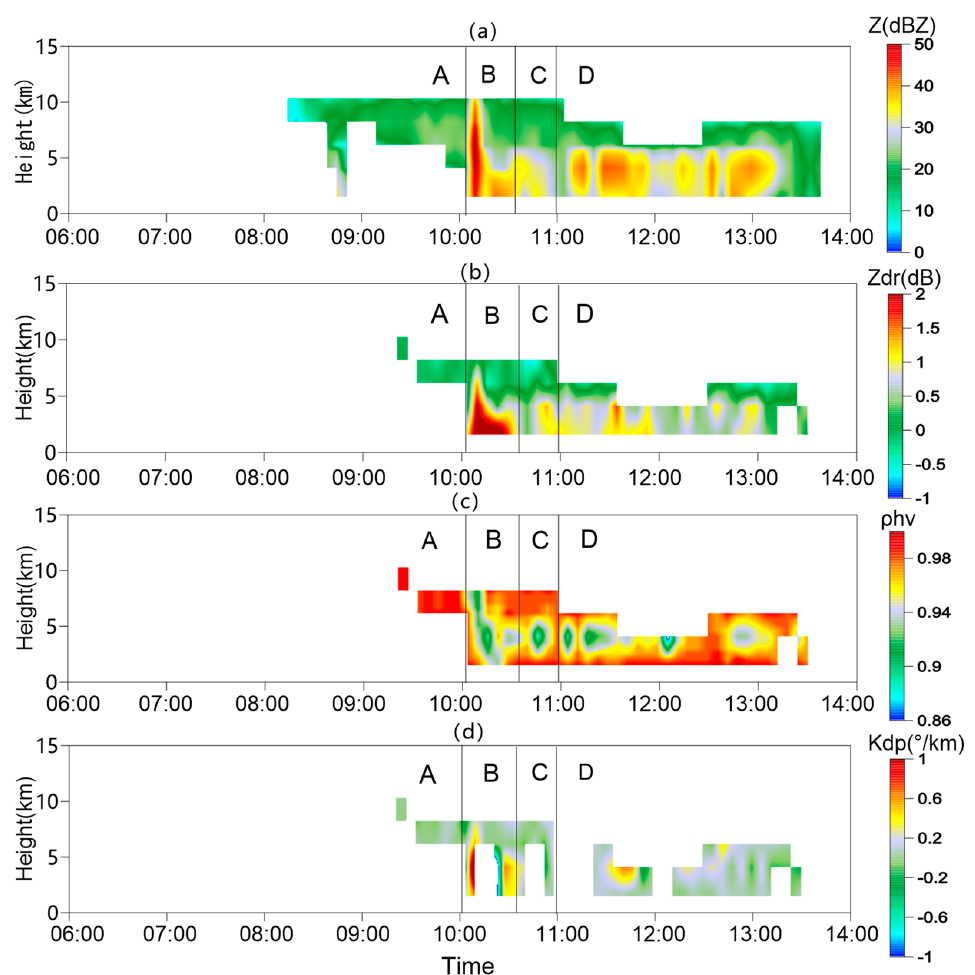
Figure 3. Time–height cross-sections of the squall line echoes observed by PR on 6 May 2016: ( a ) reflectivity factor Z (unit: dBZ), ( b ) differential reflectivity factor Z dr (unit: dBZ), ( c ) correlation coefficient ρ hv, and ( d ) specific differential phase K dp (unit: °/km). Different stages of the squall line are divided by black solid lines, and the time segment before the passage of the squall line, the strong convection time segment, the transition time segment, and the stratiform time segment are labeled A, B, C, and D, respectively.